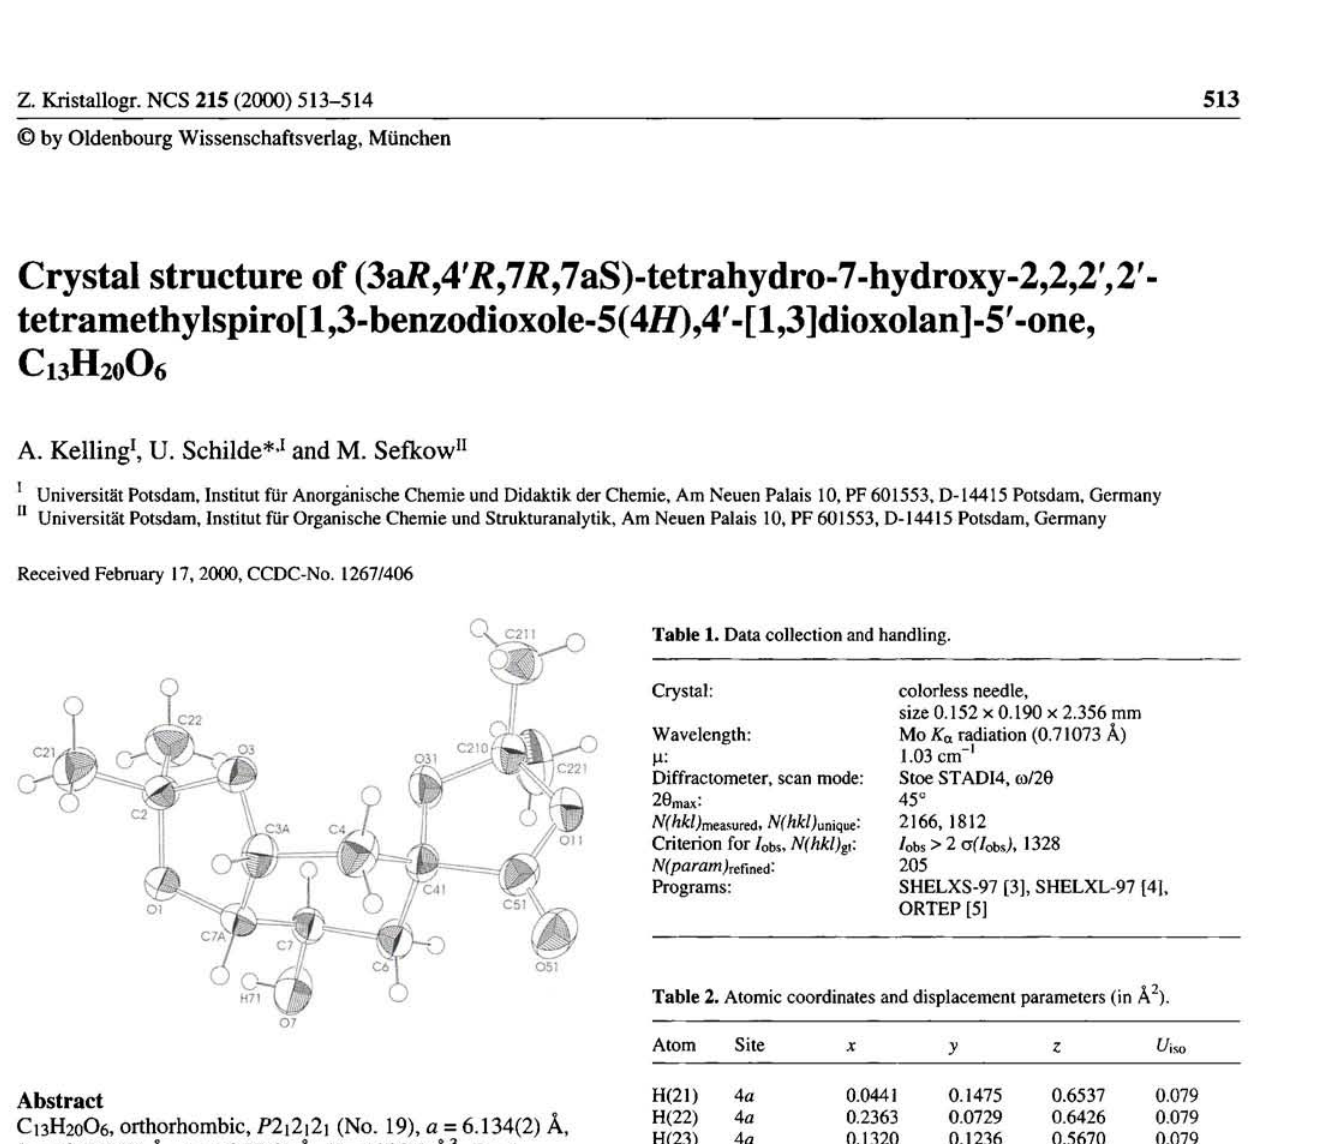
Table 2. Atomic coordinates and displacement parameters (in Ä 2 ).